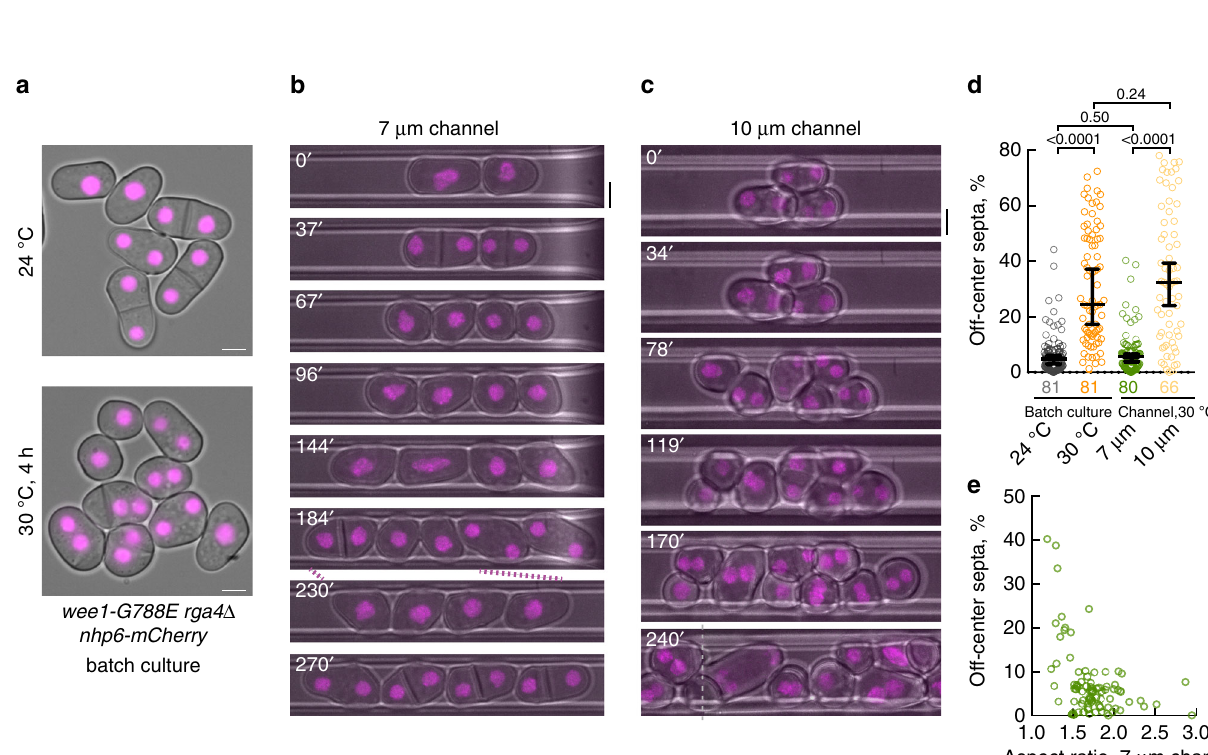
Fig. 4 Cellular geometry dictates division site positioning in S. japonicus . a Nhp6-mCherry-expressing wee1-G788E rga4 Δ cells grown in batch cultures